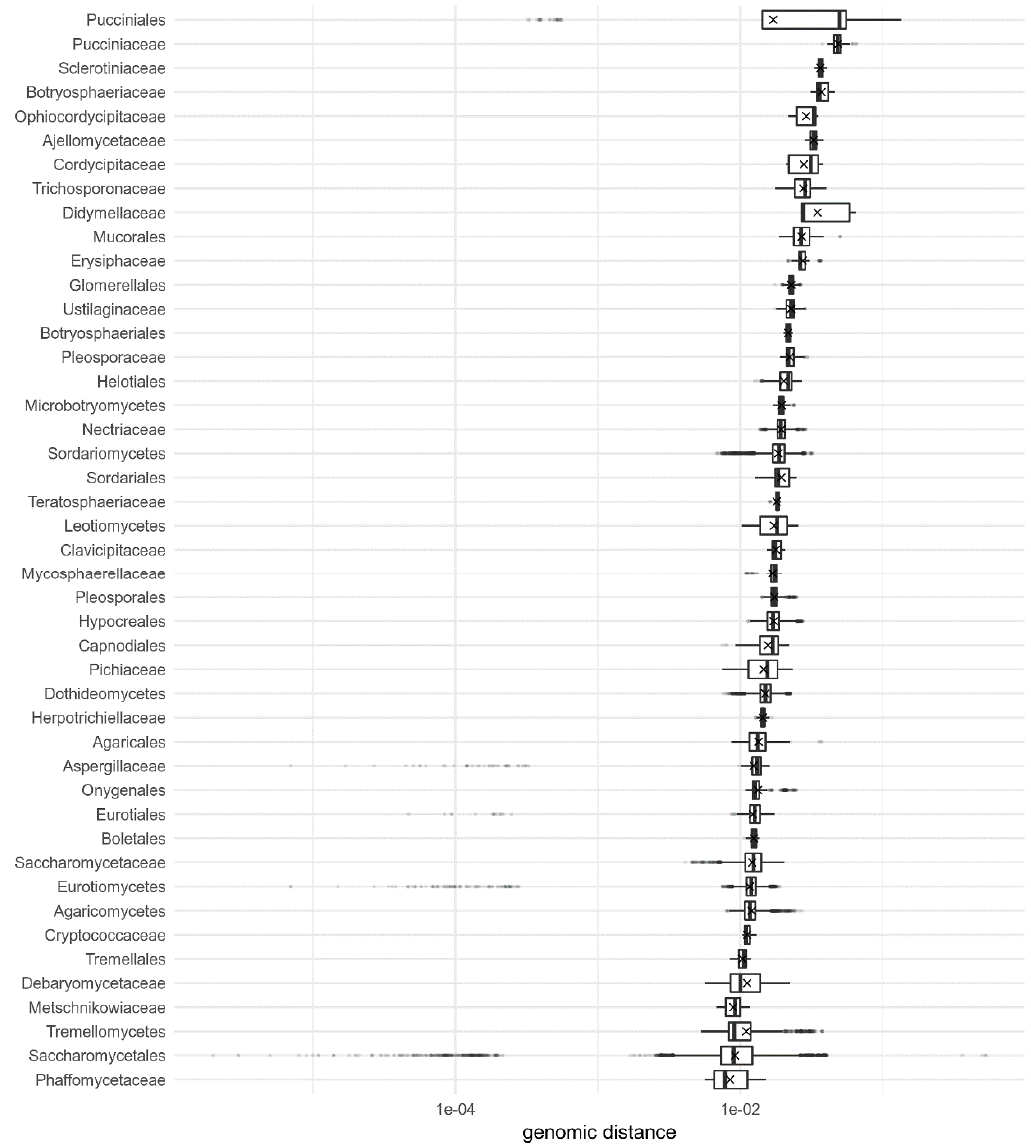
Figure 6. Pairwise genomic distances within fungal families, orders, and classes, calculated by Dashing with k-mer size 16, ordered by their median genomic distances. Distances are shown as box-and-whiskers plots, with outliers marked as dots and mean distances per genus marked with crosses. Only genera with at least 20 pairwise distances are shown.